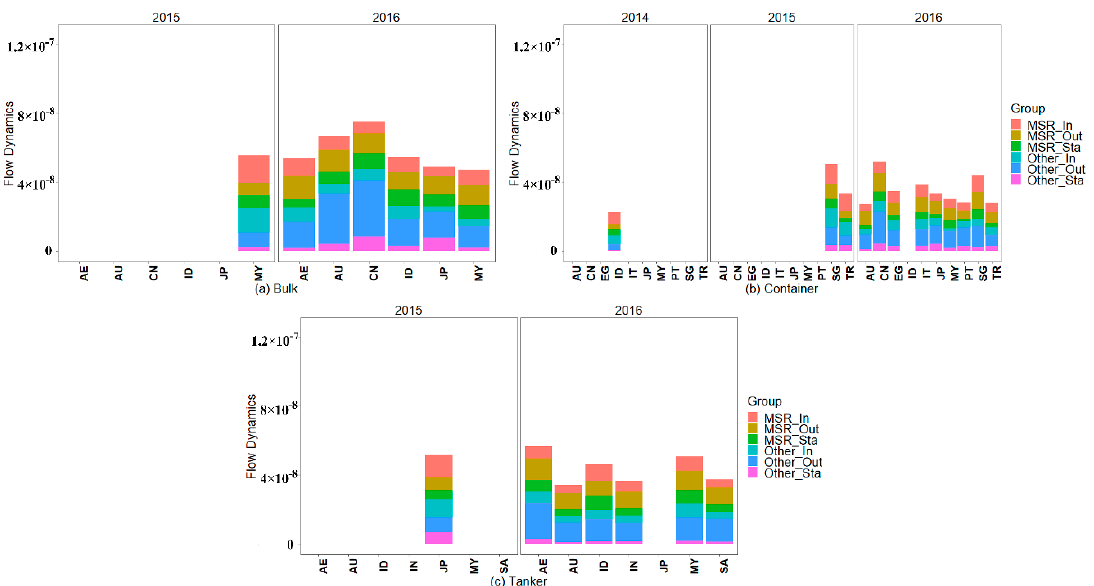
Figure 12. Tra ffi c flow weighted maritime network structure with evident dynamics. ( a ) Bulk flow Figure 12. Traffic flow weighted maritime network structure with evident dynamics. (a) Bulk flow weighted maritime network, ( b ) container flow weighted maritime, and ( c ) tanker flow weighted weighted maritime network, (b) container flow weighted maritime, and (c) tanker flow weighted maritime maritime network.